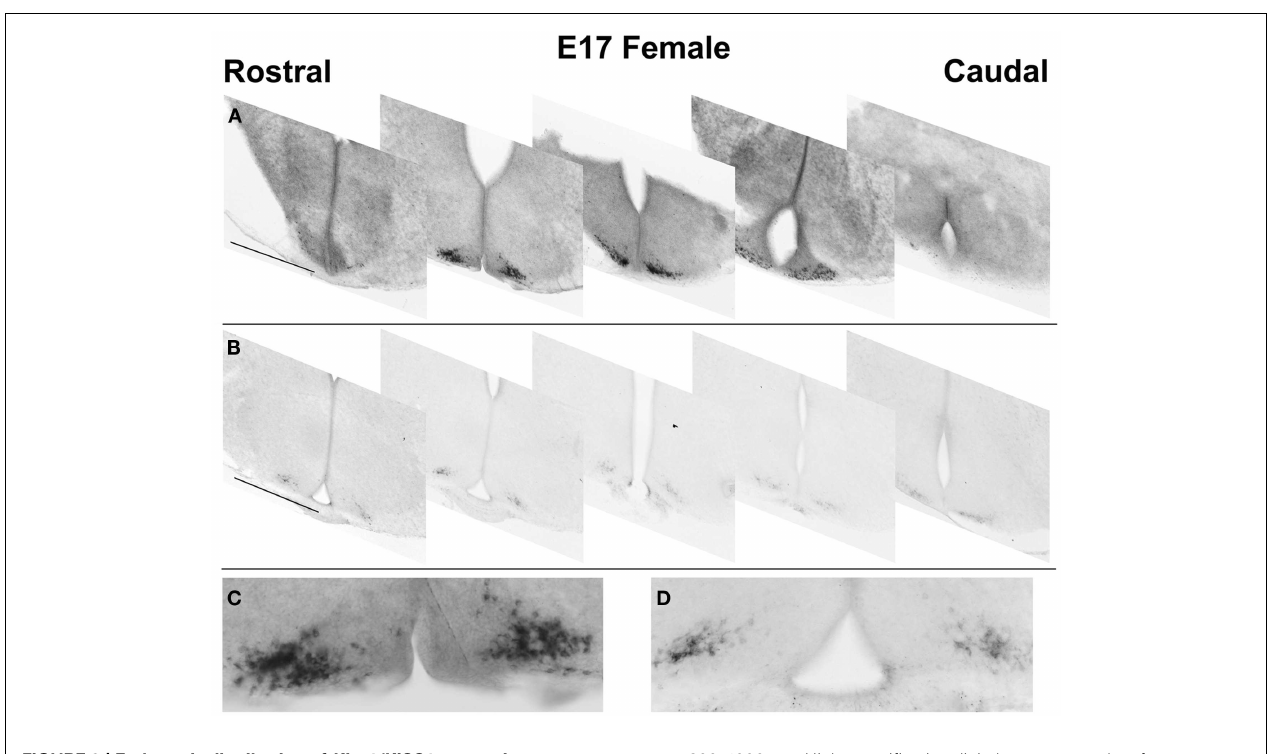
FIGURE 3 | Embryonic distribution of Kiss1/ KISS1 expressing cells . Digital images of representative sections showing the rostral-caudal distribution of cells expressing Kiss1 (A) and kisspeptin-10 immunoreactivity (B) in the ARC. Expression extends